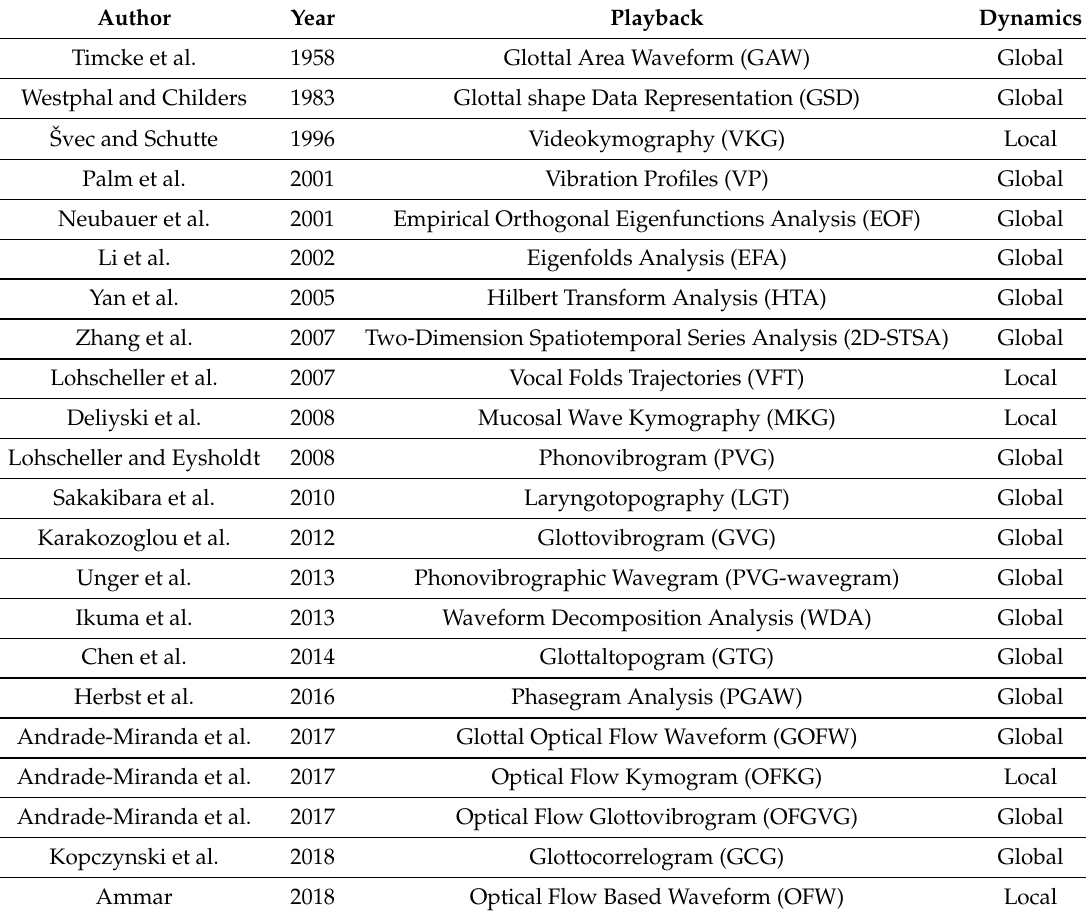
Table 4. Summary of the main studies that synthesise the vocal folds dynamics in